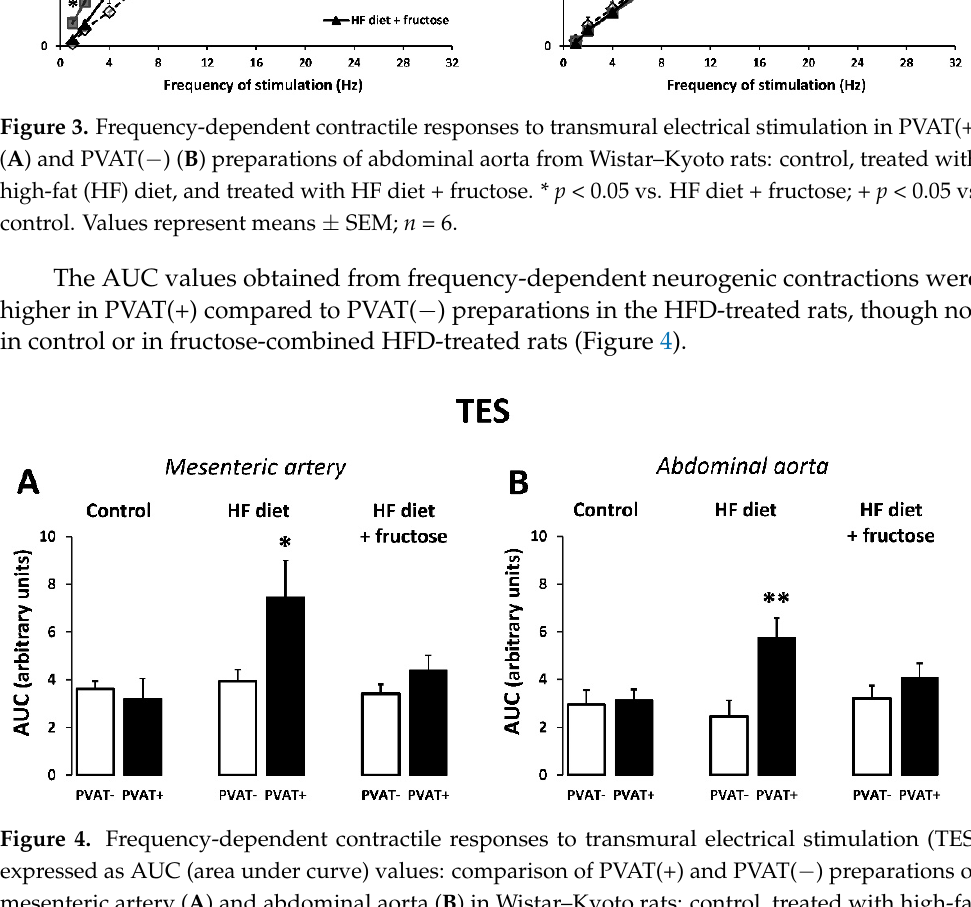
Figure 4. Frequency-dependent contractile responses to transmural electrical stimulation (TES) expressed as AUC (area under curve) values: comparison of PVAT(+) and PVAT( − ) preparations of mesenteric artery ( A ) and abdominal aorta ( B ) in Wistar–Kyoto rats: control, treated with high-fat (HF) diet, and treated with HF diet + fructose. * p < 0.05, ** p < 0.01 vs. PVAT( − ). Values represent means ± SEM; n =